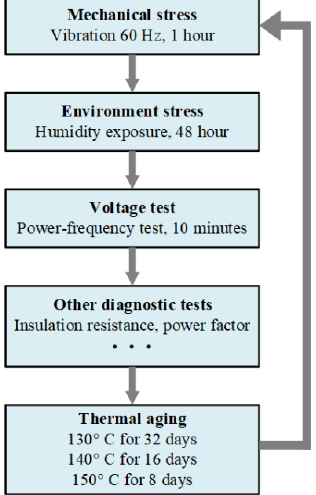
Figure 3. Accelerated thermal aging test for Class A insulation.